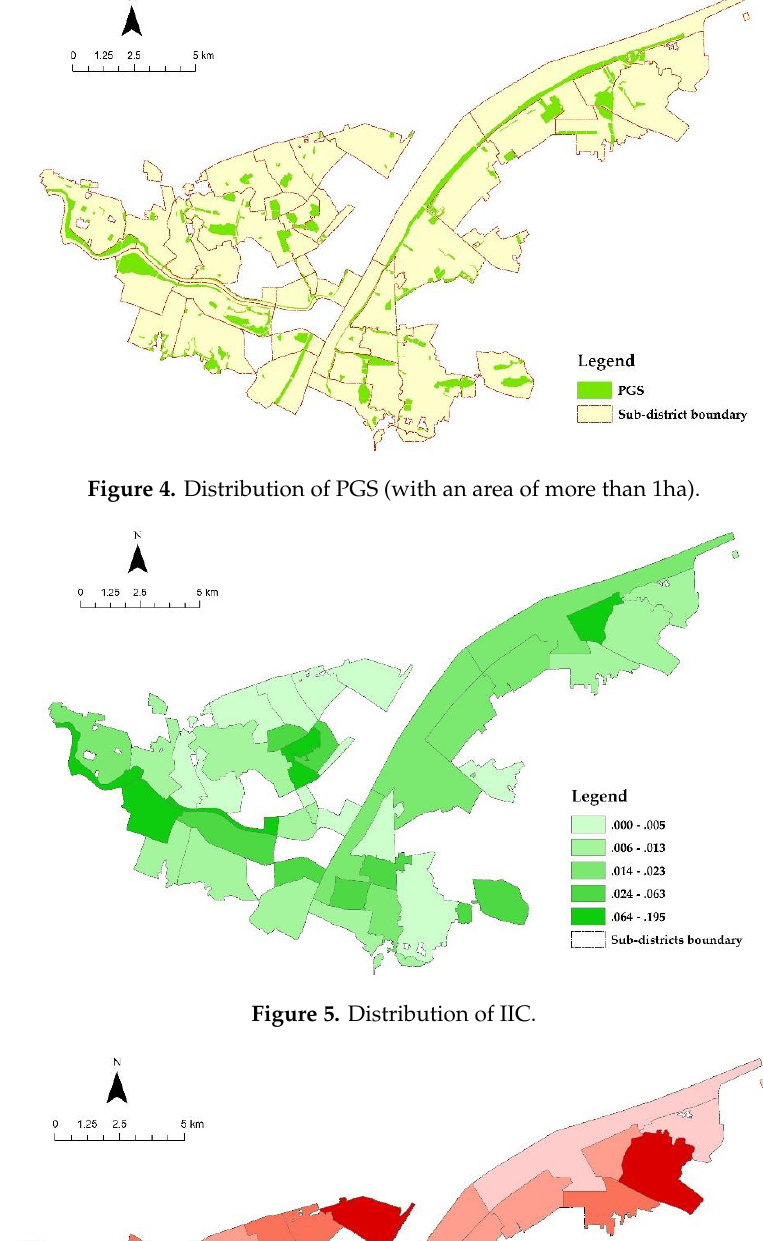
Int. J. Environ. Res. Public Health 2019 , 16 , x